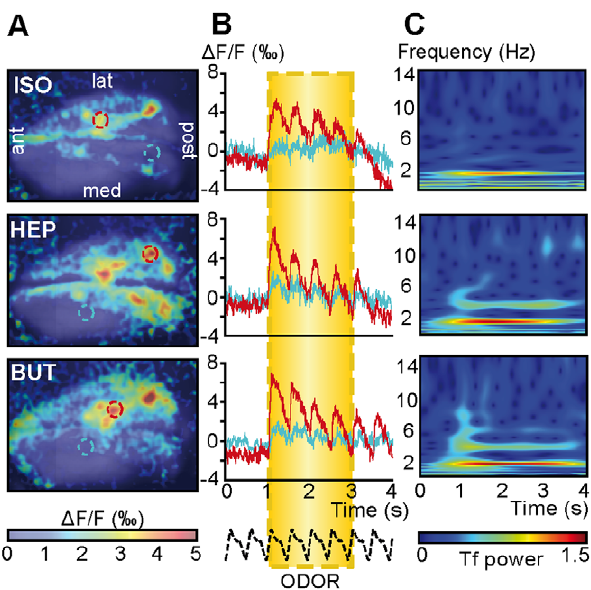
Figure 1. Odor-evoked maps at a resting sniffing frequency. A: VSDi maps evoked by three different odors. Red and blue circles indicate the regions of interest used to compute the optical signal time- course. B: Optical signal time-courses computed from the activated area (red) and non- (low)-activated area (blue). The bottom black dashed line represents the imposed sniffing signal. Yellow box indicates odor stimulation period. C: A time-frequency representation computed from the red signals displayed in B. Time-frequency power (Tf power, arbitrary unit) is color-coded (the color scale is the same for both time- frequency